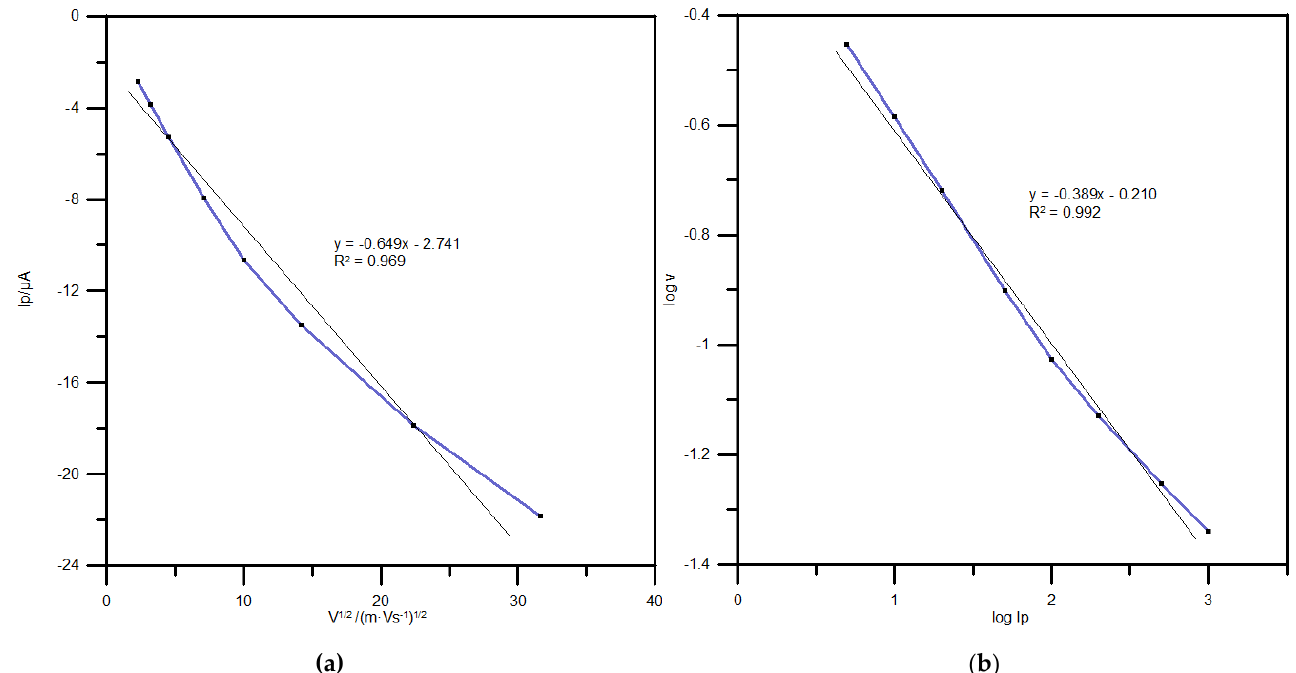
Figure 4. ( a ) Dependence of the cathodic peak current for the reduction of In(III) ( I p ) on the square root of the scan rate ( v 1/2 ). ( b ) The log-log dependence of the reduction peak current and the scan rate over the interval from 5 to 1000 mVs −1 . Each point is the average of three measurements.